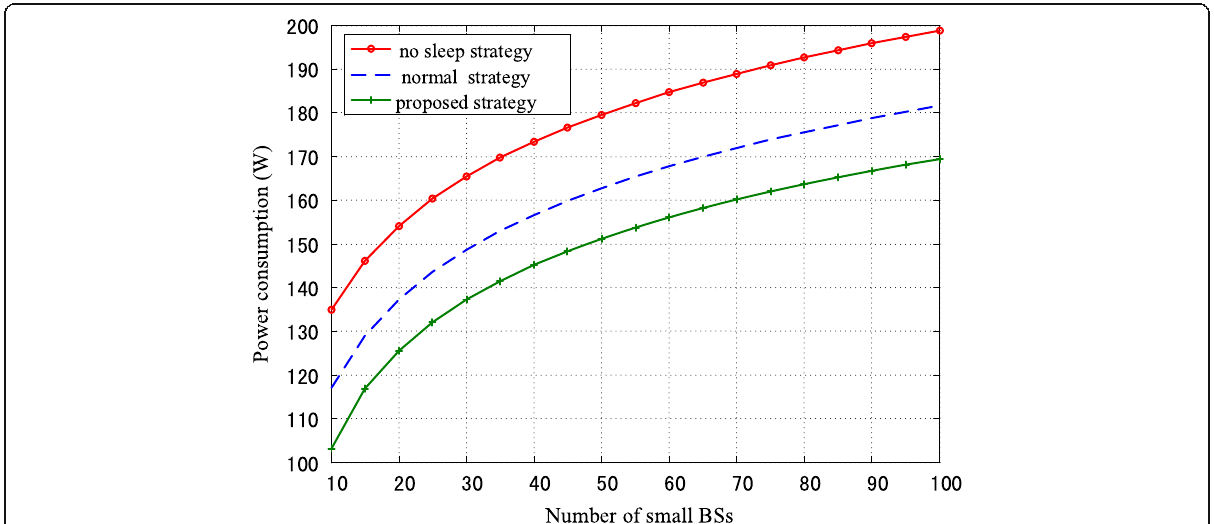
Fig. 3 Power consumption of the system. Figure 3 depicts the power consumption of the system as the number of small BSs in the system increases. We can see that for the normal sleep strategy and no sleep strategy, the power consumption increases due to the co-tier interference in dense HetNets. Specially, the proposed strategy reduces the co-tier interference by clustering and includes the sleep mechanism. Thus, the strategy can effectively reduce the power consumption of the